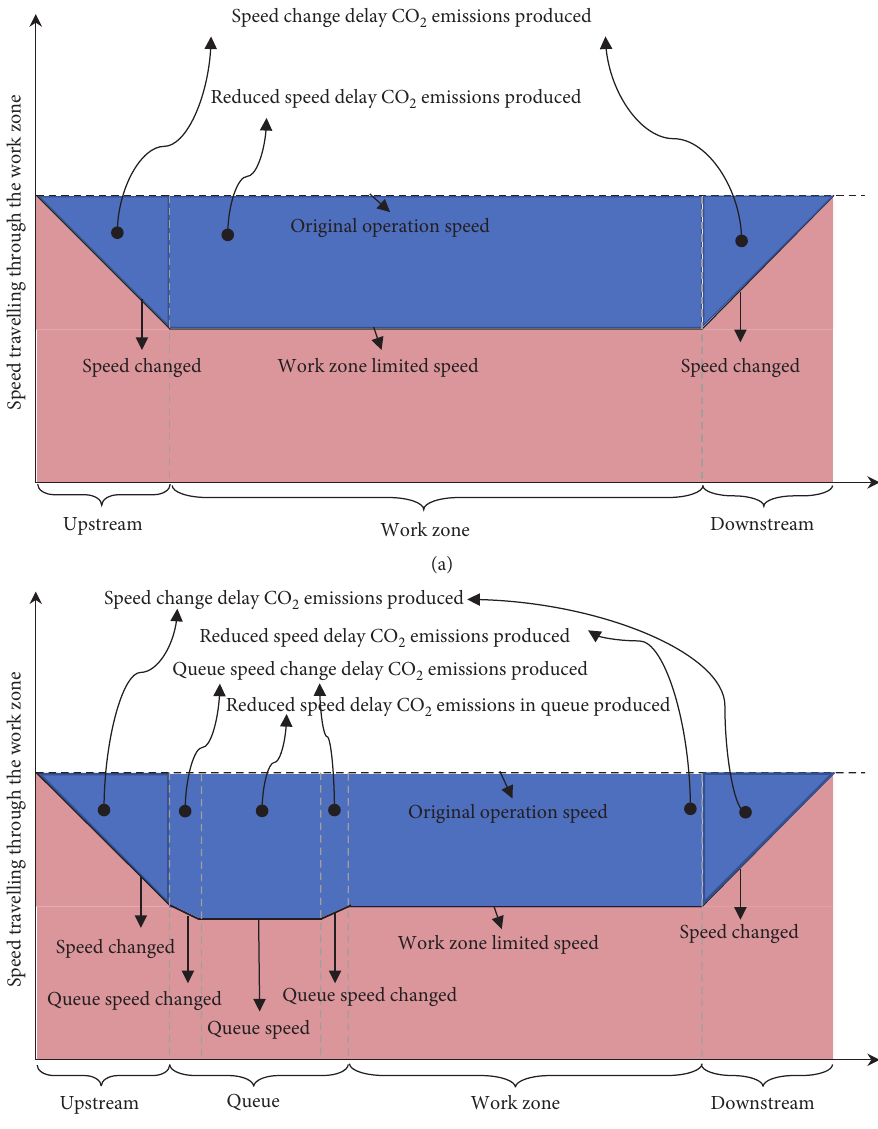
Figure 1: Vehicle operation and CO 2 emissions produced: (a) under free-flow conditions and (b) under forced-flow